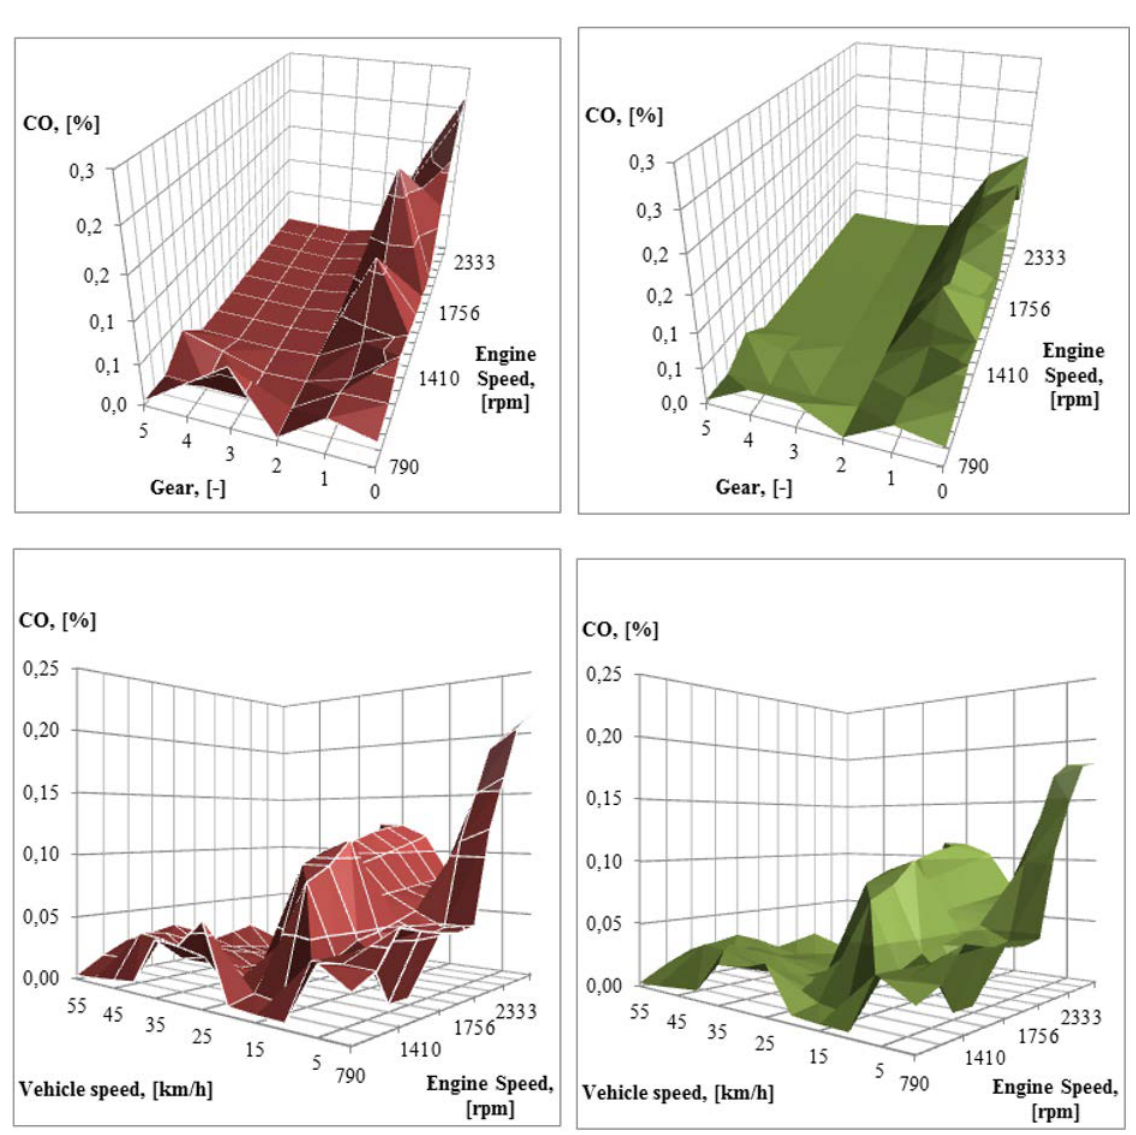
Figure 15. Carbon oxide emissions. a. CO versus engine speed for different gear ratios in standard operating conditions; b. CO versus engine speed for different gear ratios with IAP operation; c. CO versus engine speed for different vehicle speeds in standard operation; d. CO versus engine speed for different vehicle speeds with IAP